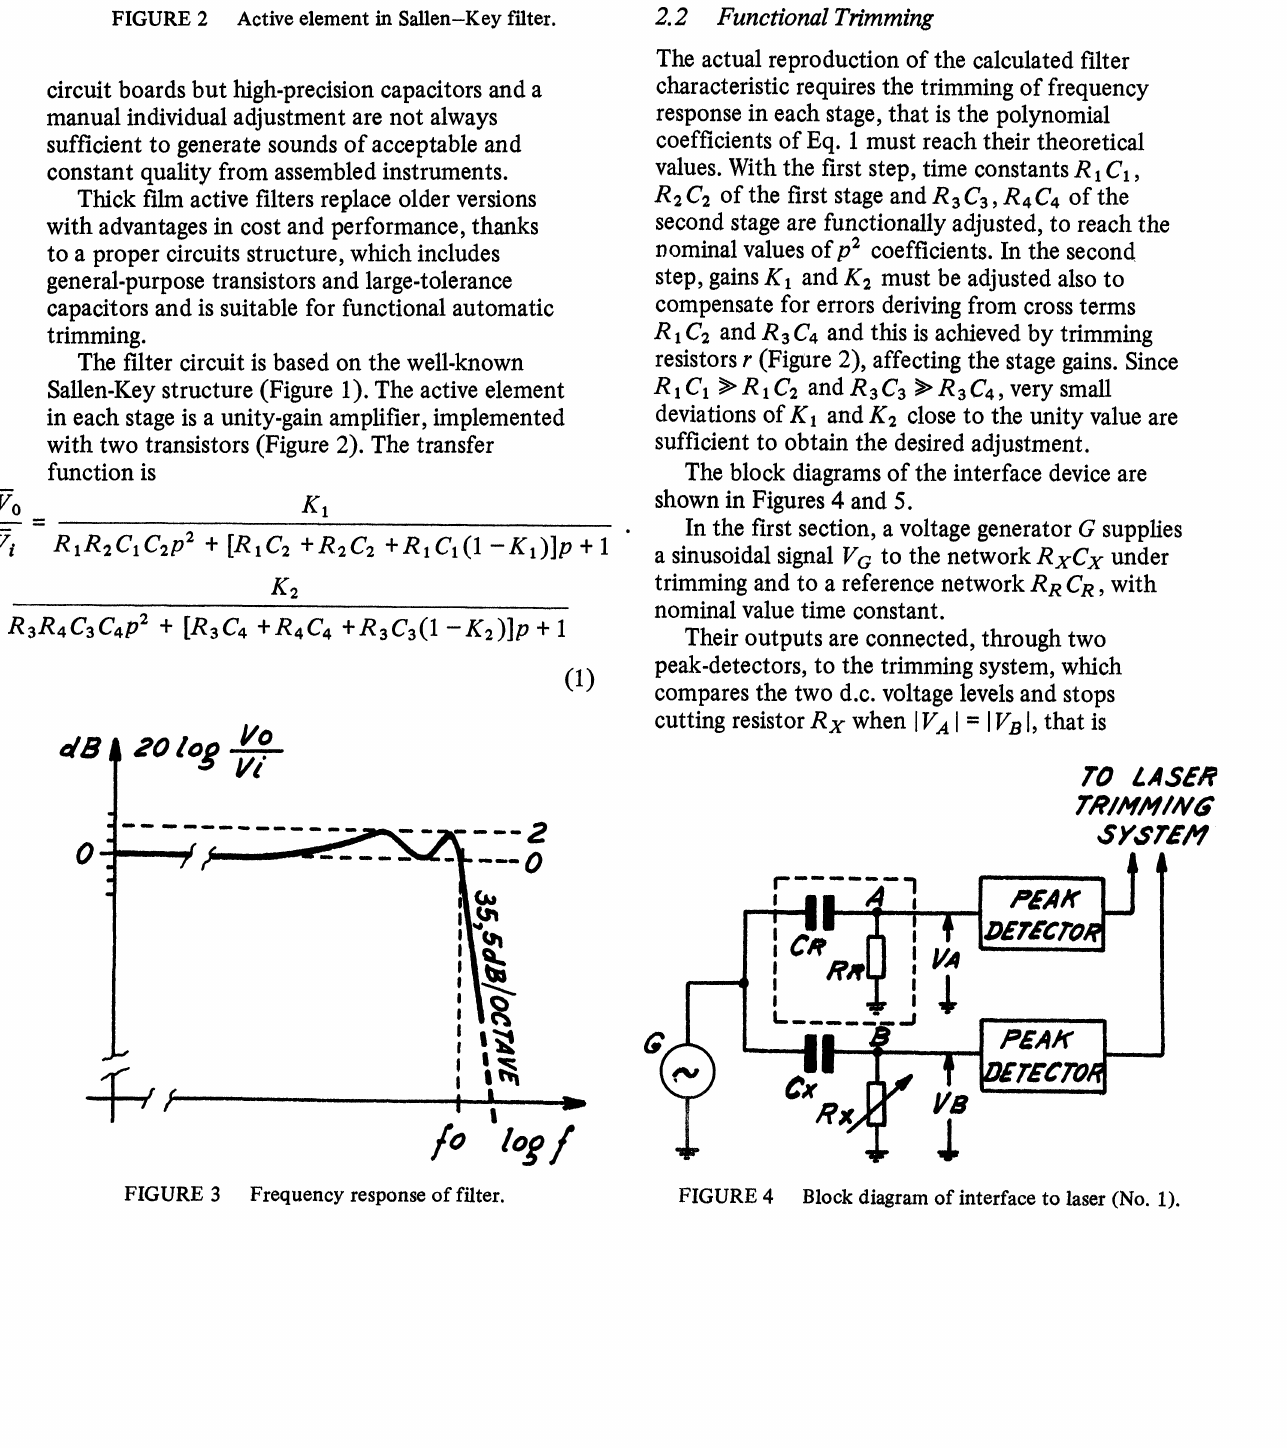
FIGURE 3 Frequency response of filter. FIGURE 4 Block diagram of interface to laser (No.